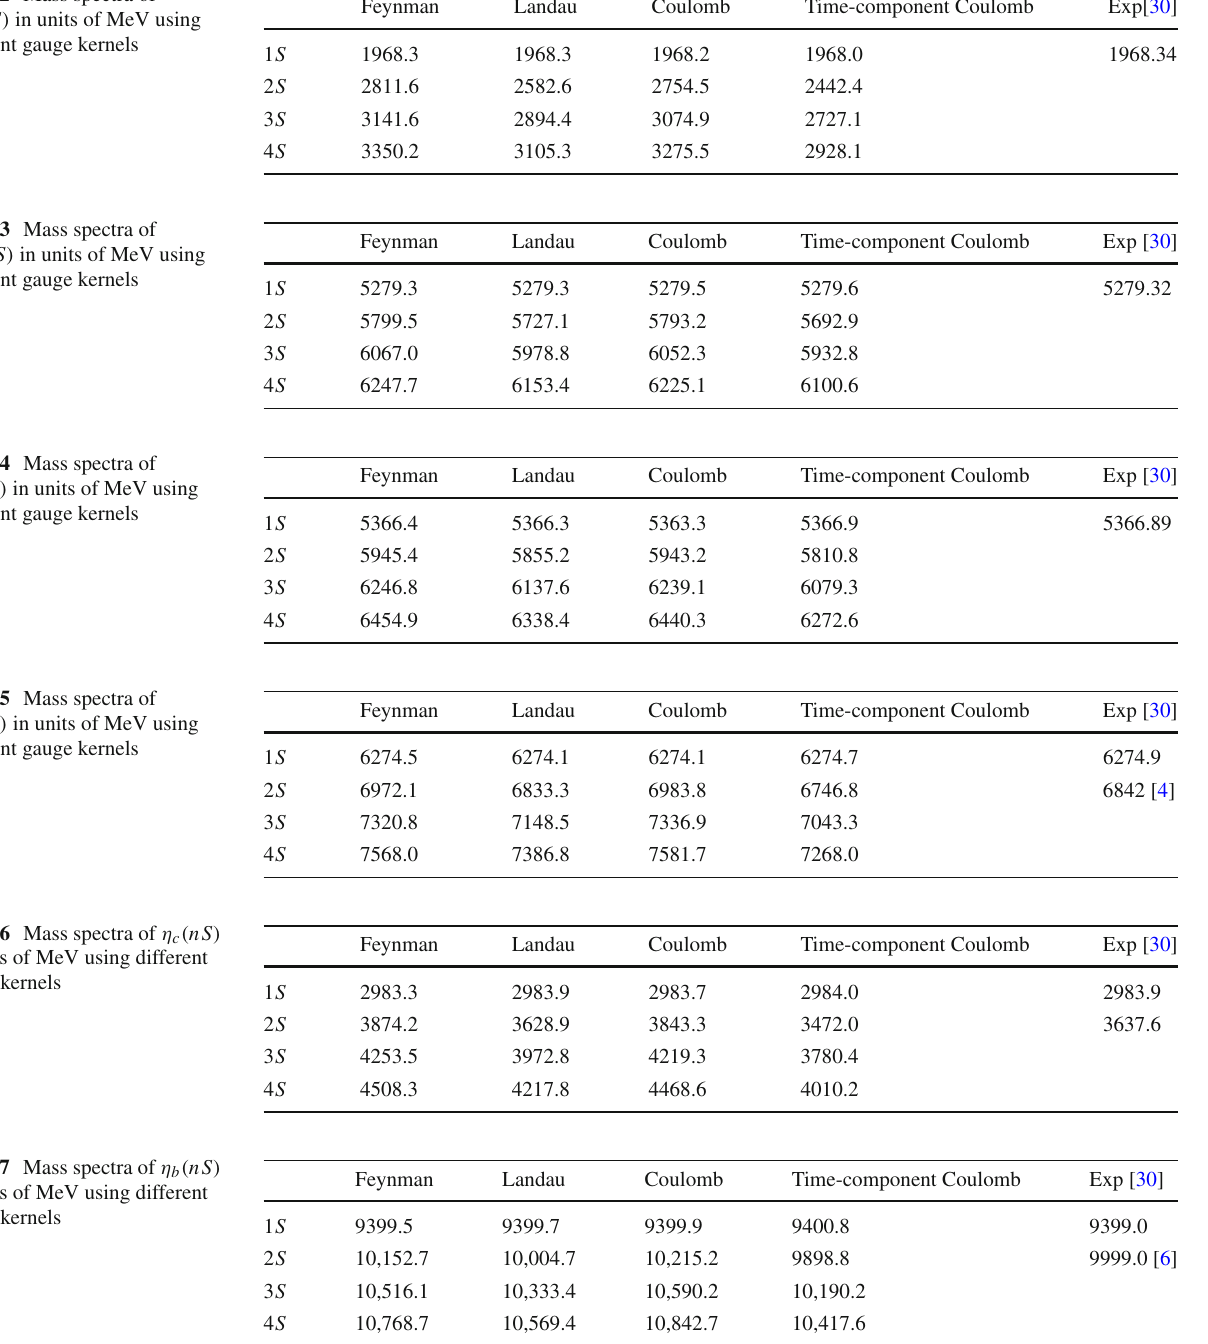
Table 2 Mass spectra of D